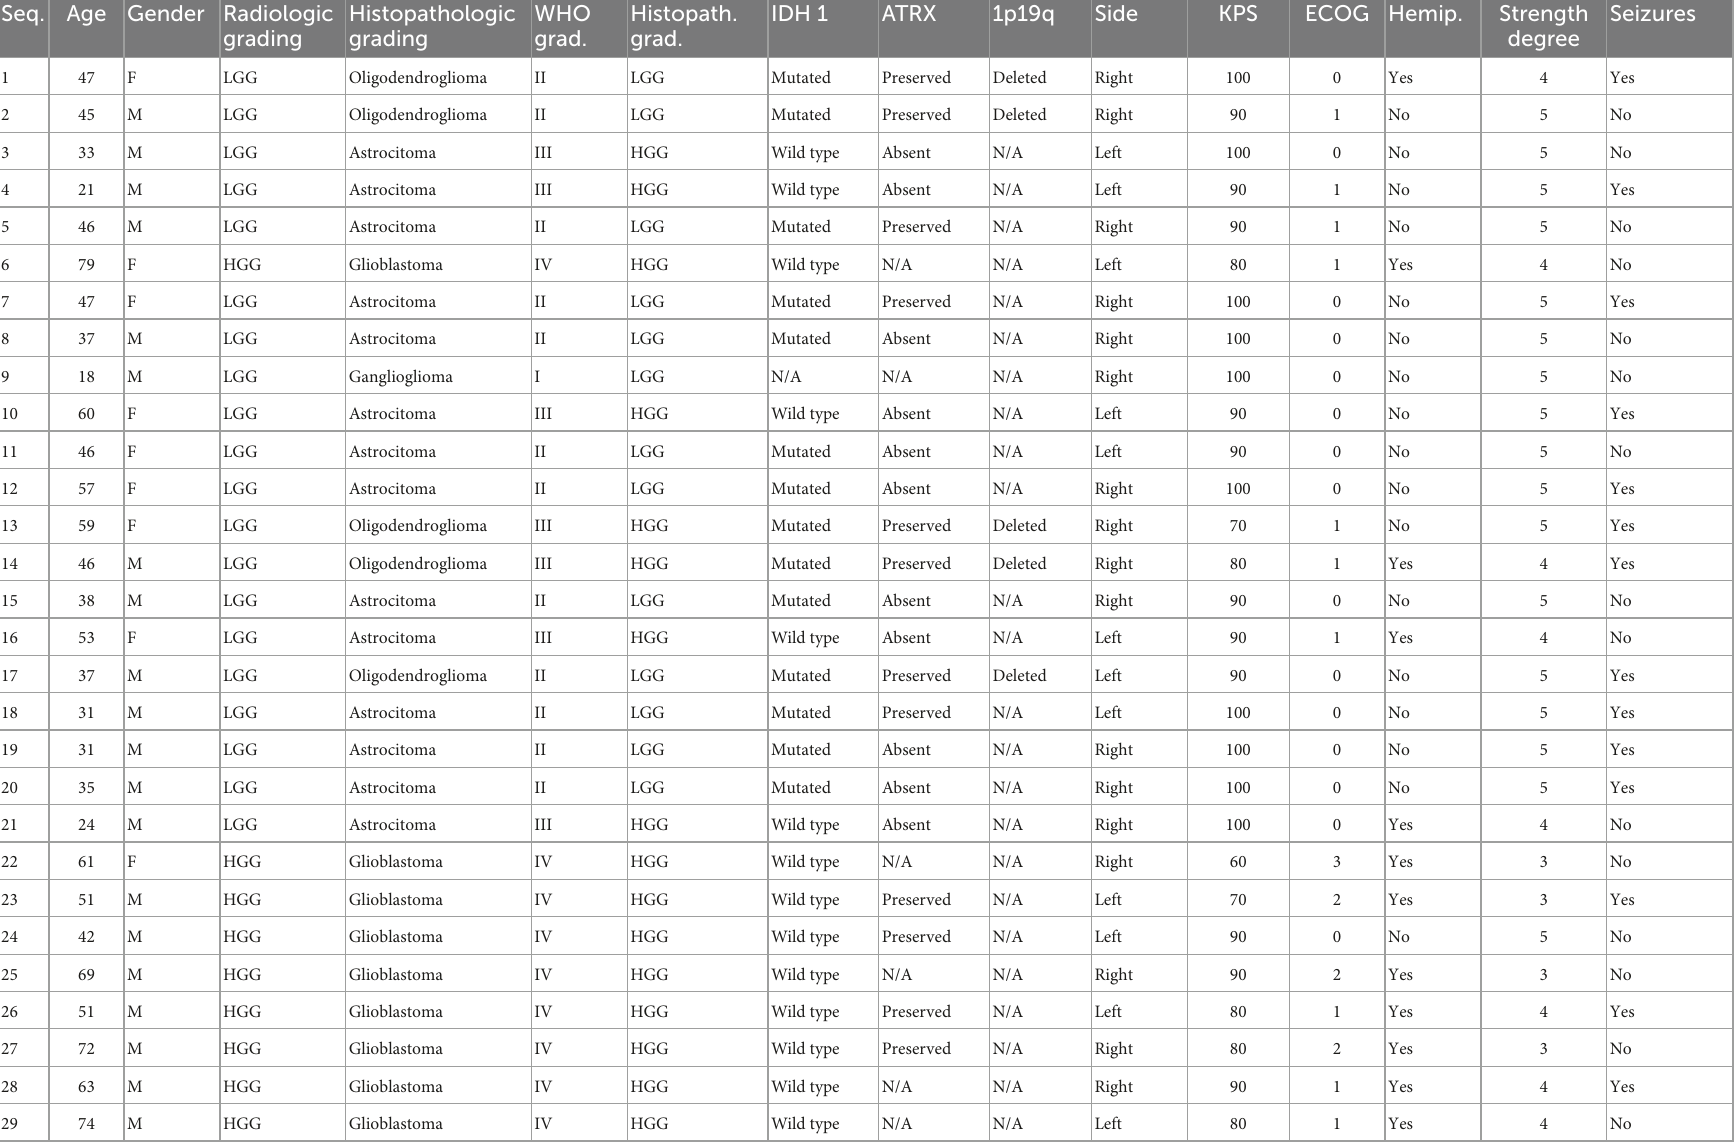
TABLE 1 General characteristics of the study